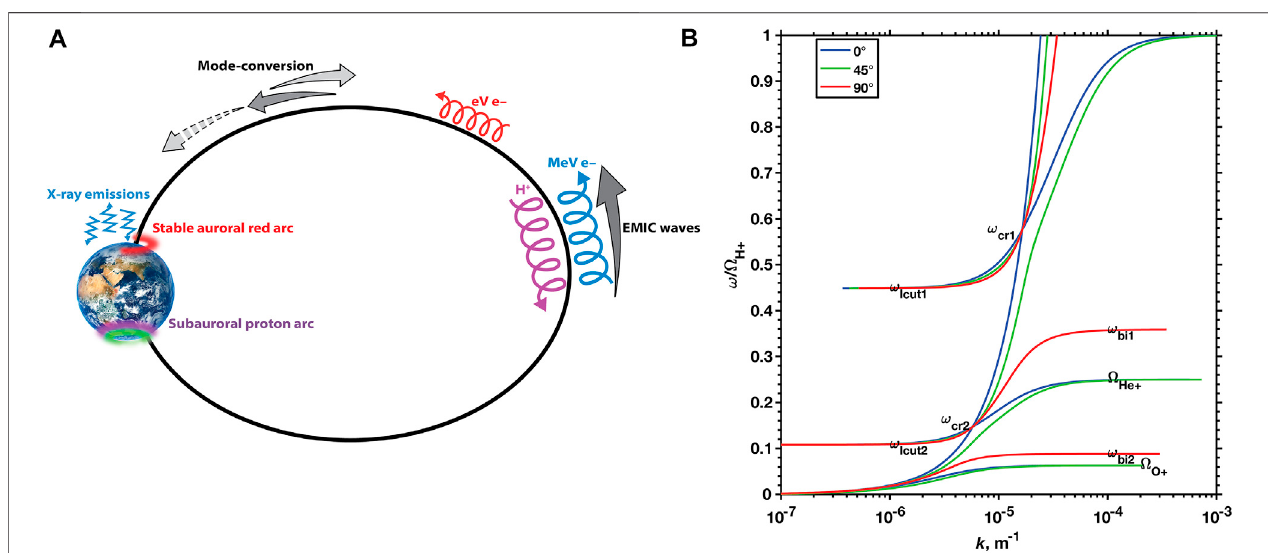
FIGURE1|(A) Conceptual overviewofprocessesrelated toEMICwavesgeneratedinEarth ’ smagnetosphereincludingwavemodeconversionenabledbyheavy ion presence, the wave impacts on various particle populations, and manifestation ofthe wave impacts sometimes observed at low altitudes. (B) The dispersion relation (normalized frequency versus wave number) of cold plasma waves below the proton gyrofrequency in a uniform and magnetized plasma with ion composition 70% H + , 20% He + , 10% O + . Background magnetic fi eld is 248 nT (corresponding to the equatorial magnetic fi eld strength at L (cid:1) 5) and background electron density of 50 cm − 3 is used. Three values of wave normal angles, 0 ° , 45 ° , and 90 ° are represented by blue, green and red lines respectively. Characteristic frequencies (crossover, cutoff and bi-ion resonant frequencies) are denoted, with subscripts 1 and 2 representing frequencies between H + and He + gyrofrequencies and between O + and He + gyro frequencies, respectively. Calculation of those characteristic frequencies can be found elsewhere (e.g., Chen et al.,